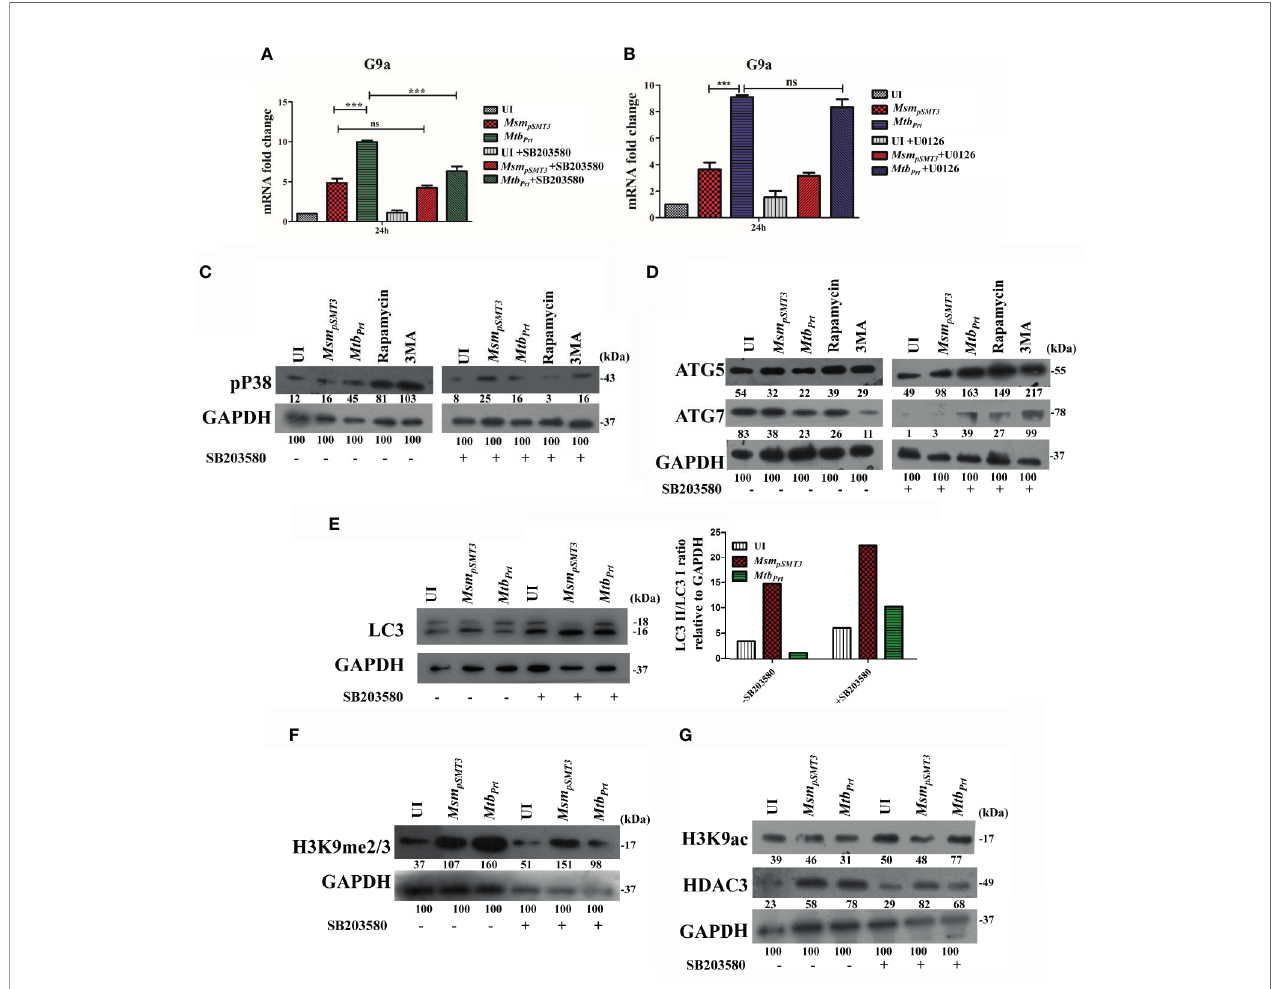
FIGURE 4 | Role of MAPK in H3K9 hypermethylation and autophagy inhibition. Expression of G9a transcripts was checked in RAW264.7 cells infected with Msm pSMT3 and Mtb Prt followed by treatment with (A) SB203580 and (B) U0126 for 24 h. Expression of (C) p-P38, (D) ATG5 and ATG7, (E) LC3-I to II conversion (Densitometry is representative to the particular western blot data), (F) H3K9me2/3, (G) H3K9ac and HDAC3 were checked in RAW cells infected with Msm pSMT3 and Mtb Prt in presence and absence of SB203580 (P38 inhibitor) for 24 h. The experiments were performed in triplicate (n=3). Msm pSMT3- Msm harbouring pSMT3 plasmid; Mtb Prt - recombinant Msm expressing MtbPrt (Rv3242c) . Results are shown as mean ± S.D. ***p < 0.001; ns, not signi fi